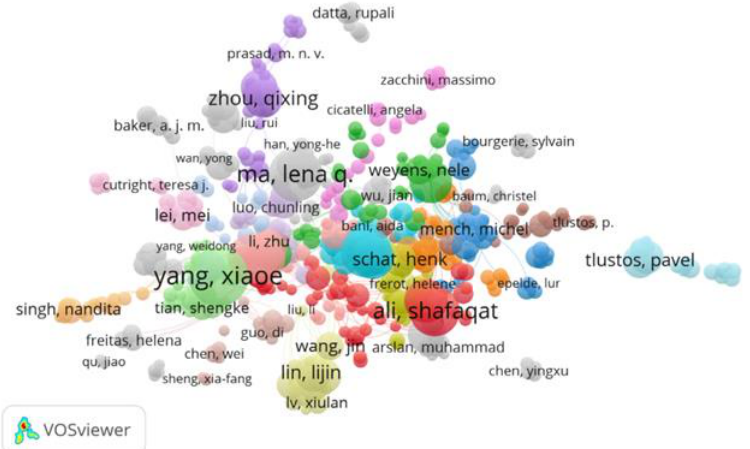
Figure 2. Co-authorship network map of authors. There are 31 clusters with a total of 1634 links and a total link strength (TLS) of 8122.Larger nodes indicate that the researcher has more publications. Lines connecting clusters indicate a collaboration between the researchers, which is stronger when the line is thicker. Note that this is produced by VOSviewer and the content cannot be